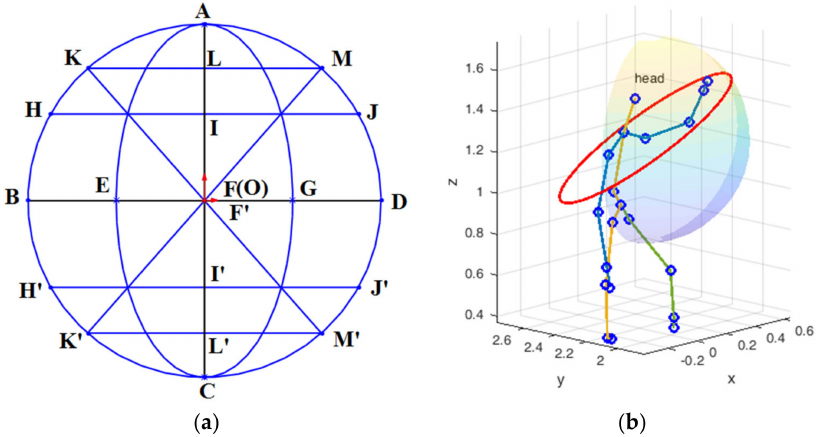
Figure 4. The designed fish trajectory and the game scene: ( a ) the designed fish trajectory, ( b ) game scene in three-dimensional